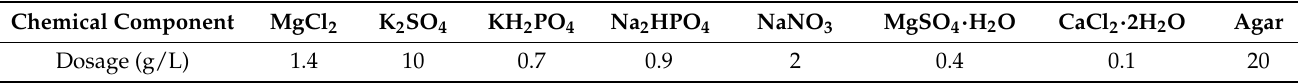
Table 1. The ingredients of the modified medium used for bacterial cultivation. Chemical Component MgCl 2 K 2 SO 4 KH 2 PO 4 Na 2 HPO